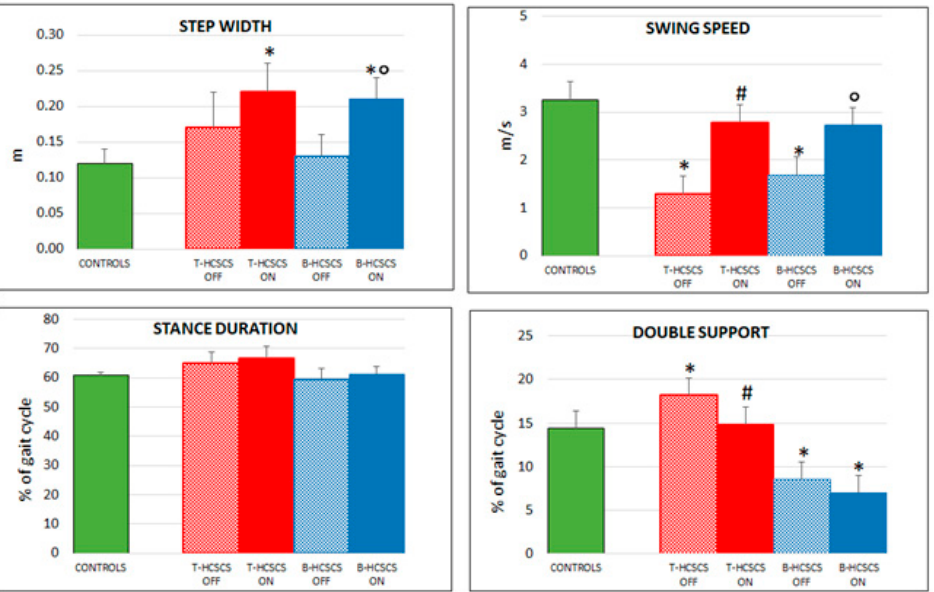
Figure 5. Improvement of spatiotemporal gait parameters (gait speed, cadence, step length, stride length, step width, swing speed, stance duration, double support) in the two groups of